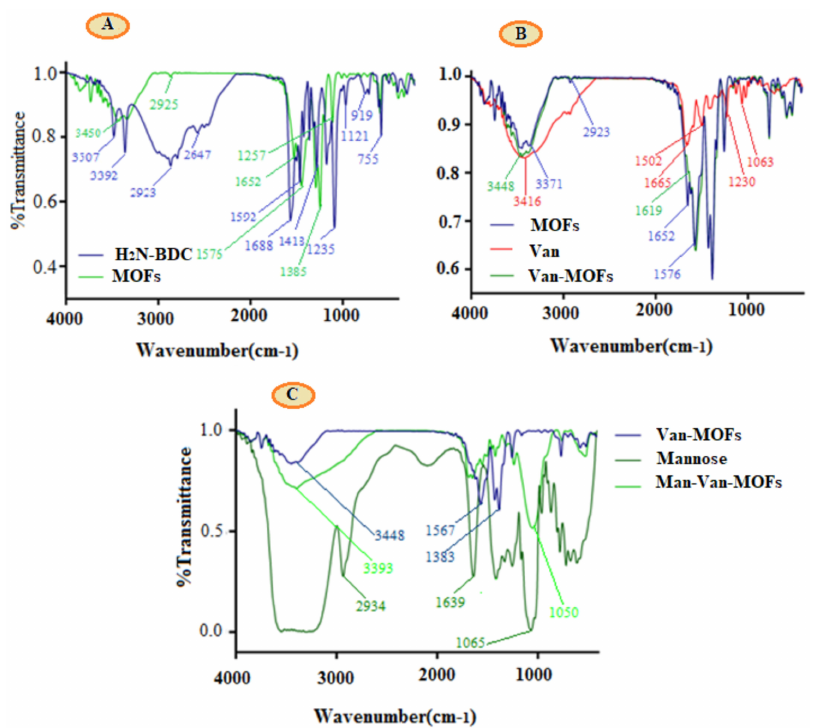
Figure 1. FTIR spectra of NH 2 − BDC and MOFs ( A ), MOFs, VCM and VCM − MOFs ( B ). MNS, VCM − MOFs and MNS − VCM − MOFs ( C